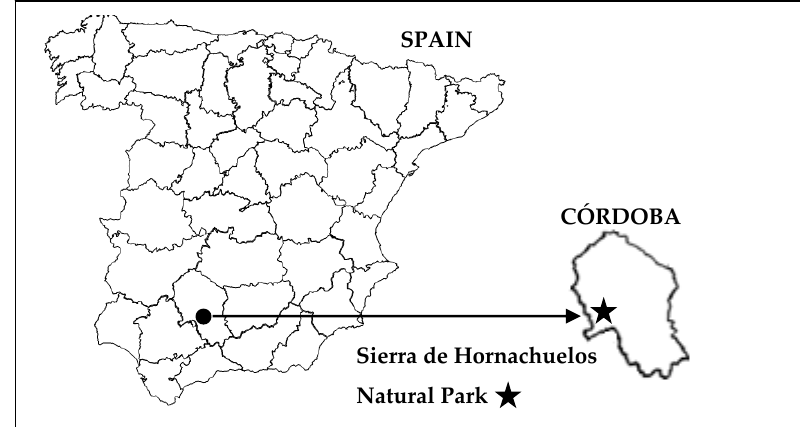
Figure 1. Location of the research area [10].